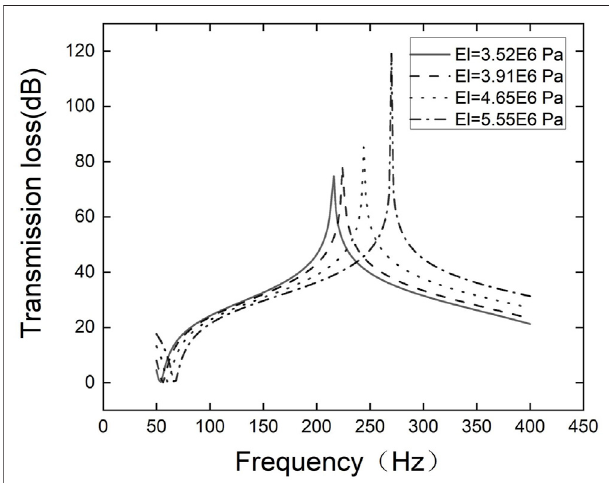
FIGURE4| Performancecurvesforsoundinsulationof fi lmsofthesame material for various magnetic fi eld strengths.